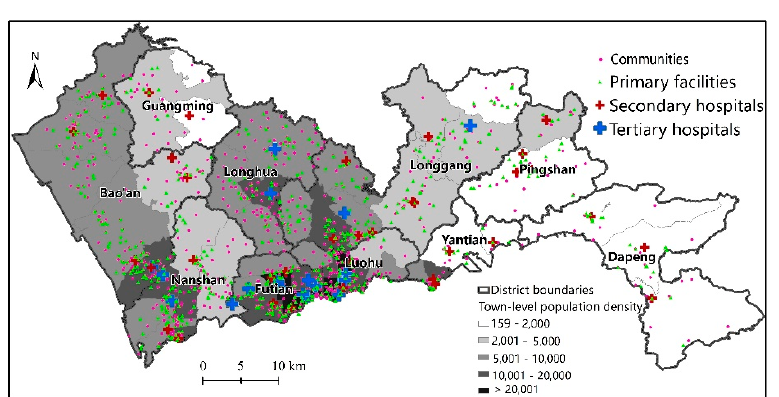
Figure 1. The distribution of communities, town-level population density and hierarchical healthcare facilities in